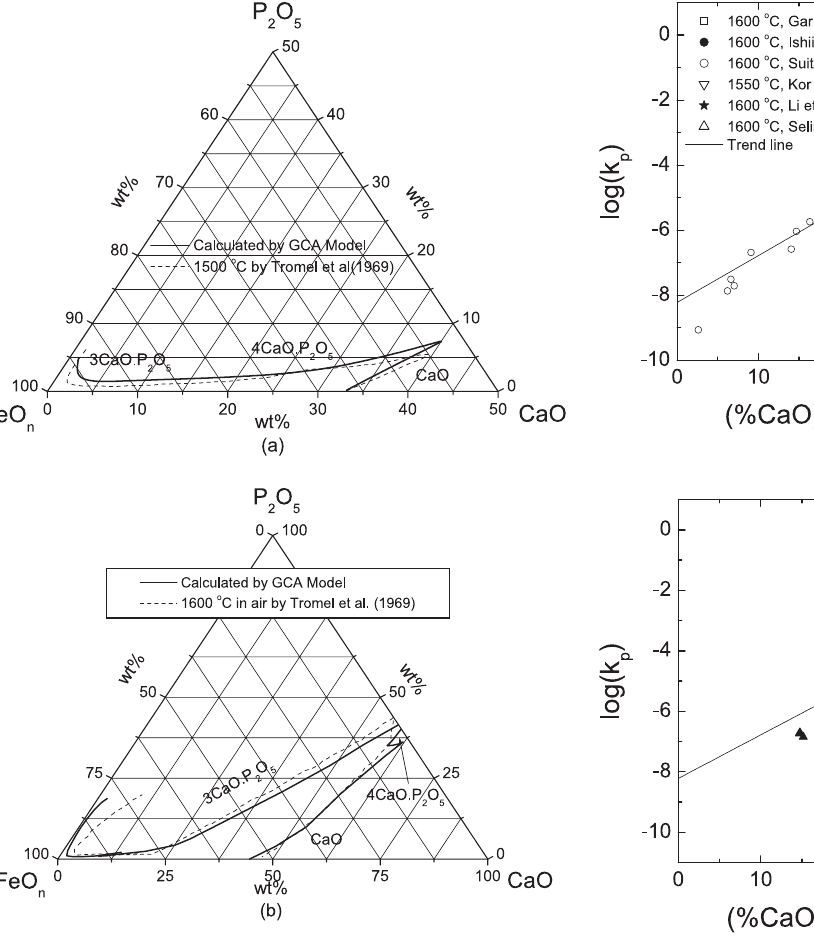
Fig. 2: Comparison between the calculated Fe saturated liquidus at 1500°C (a) and liquidus at 1600°C in air (b) by the GCA model and the experimental data [11, 12] in the Fe saturated CaO-P